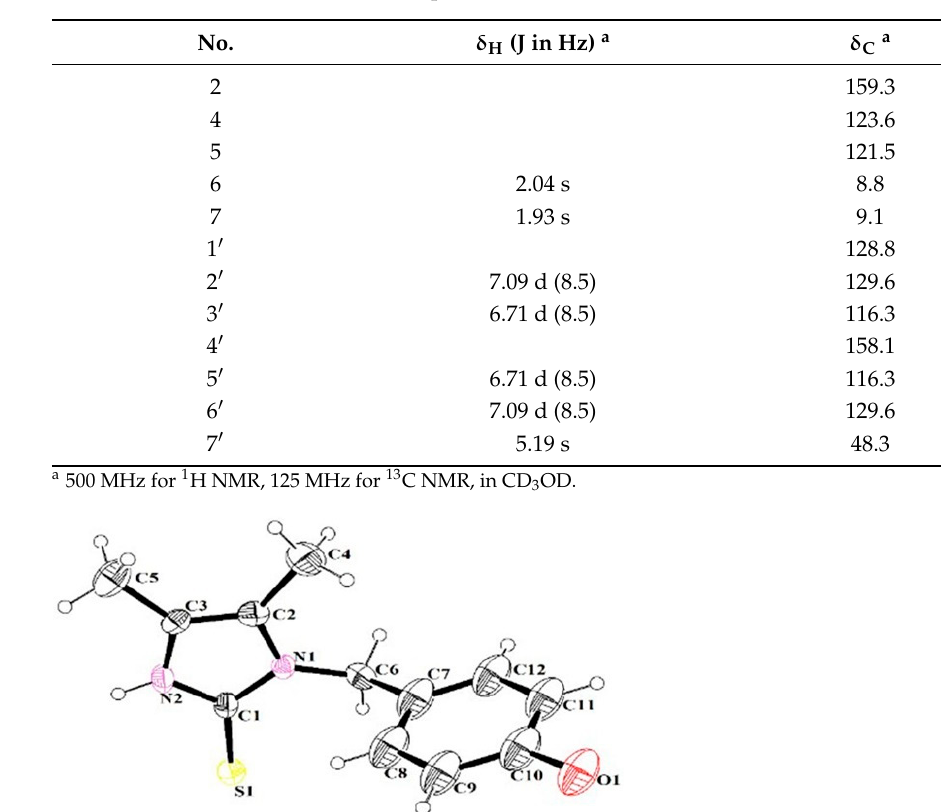
Table 2. 1 H and 13 C NMR data of compound 2 in CD 3 OD.